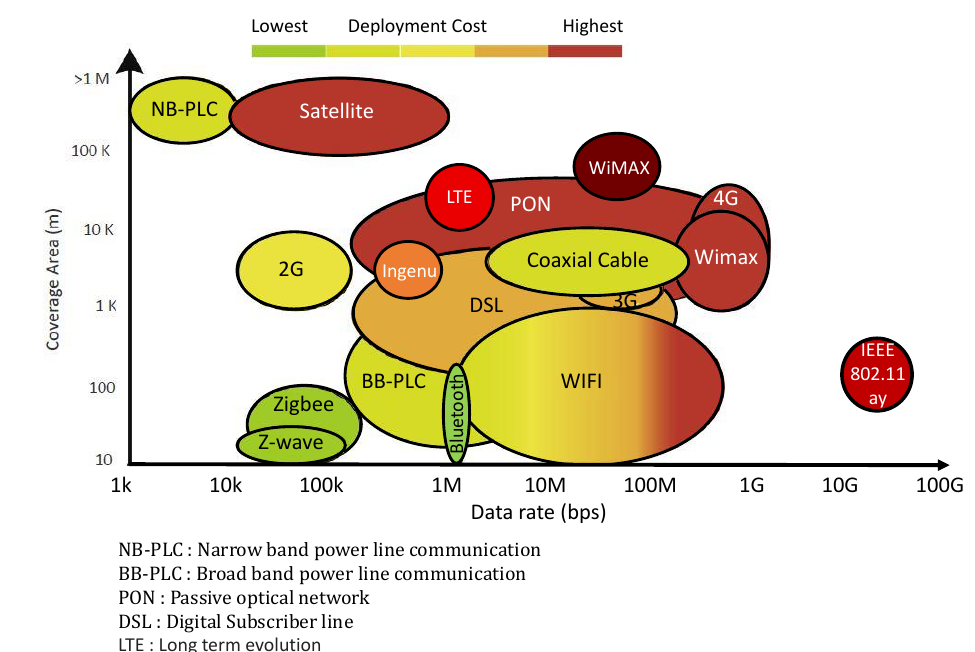
Figure 5. Communication technologies comparison in terms of coverage area and data rate for MGs data exchange